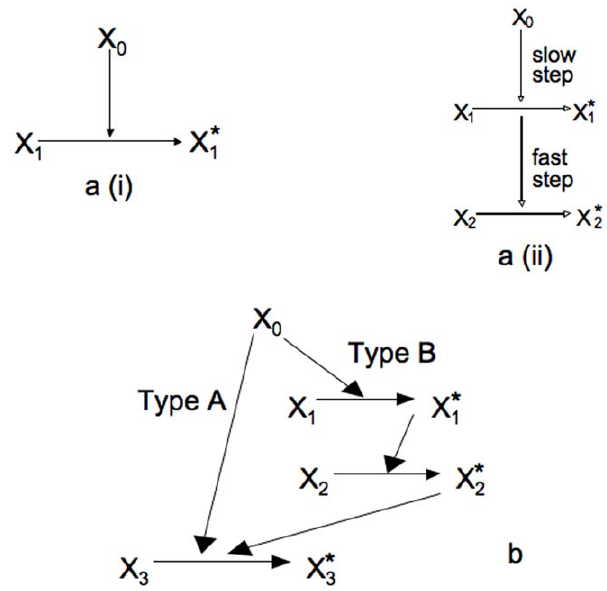
Figure 1. Schematics of minimal signaling networks. (a) Schematics of a minimal deterministic signaling network (i), and the same for a two-step signaling network with slow stochastic activation (ii). (b) Schematics of the minimal signaling network.